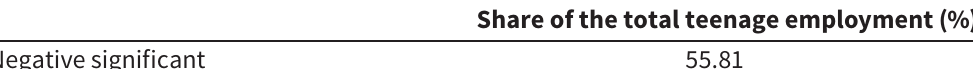
Table 4 Percentage of the teenage employment by the significance of the minimum wage effects depending on the monopsony